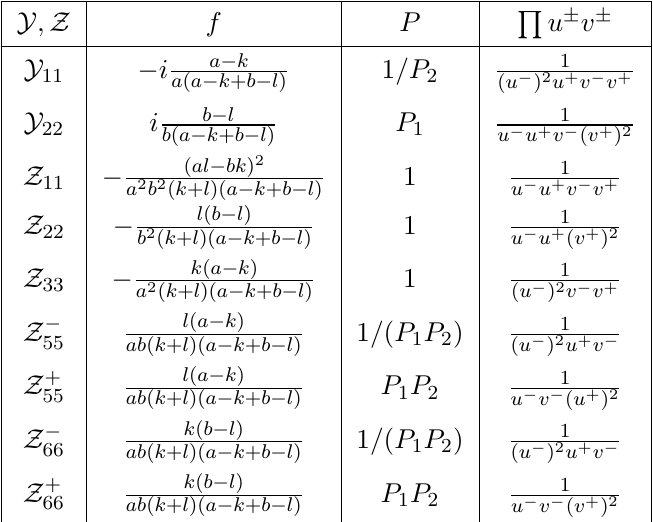
Table 1 . The diagonal elements of the bound-state S -matrix that factor at the poles of the measure, and their dressing by u (cid:6) ; v (cid:6)